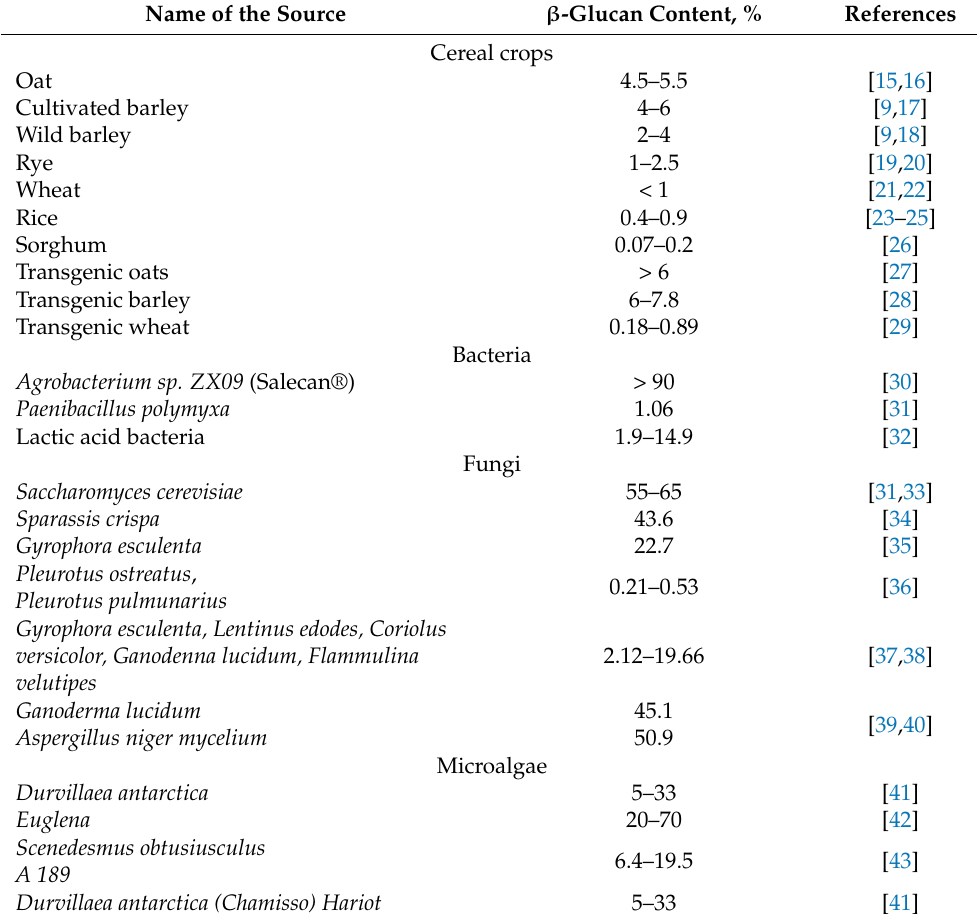
Table 1. β -glucan content with different sources of